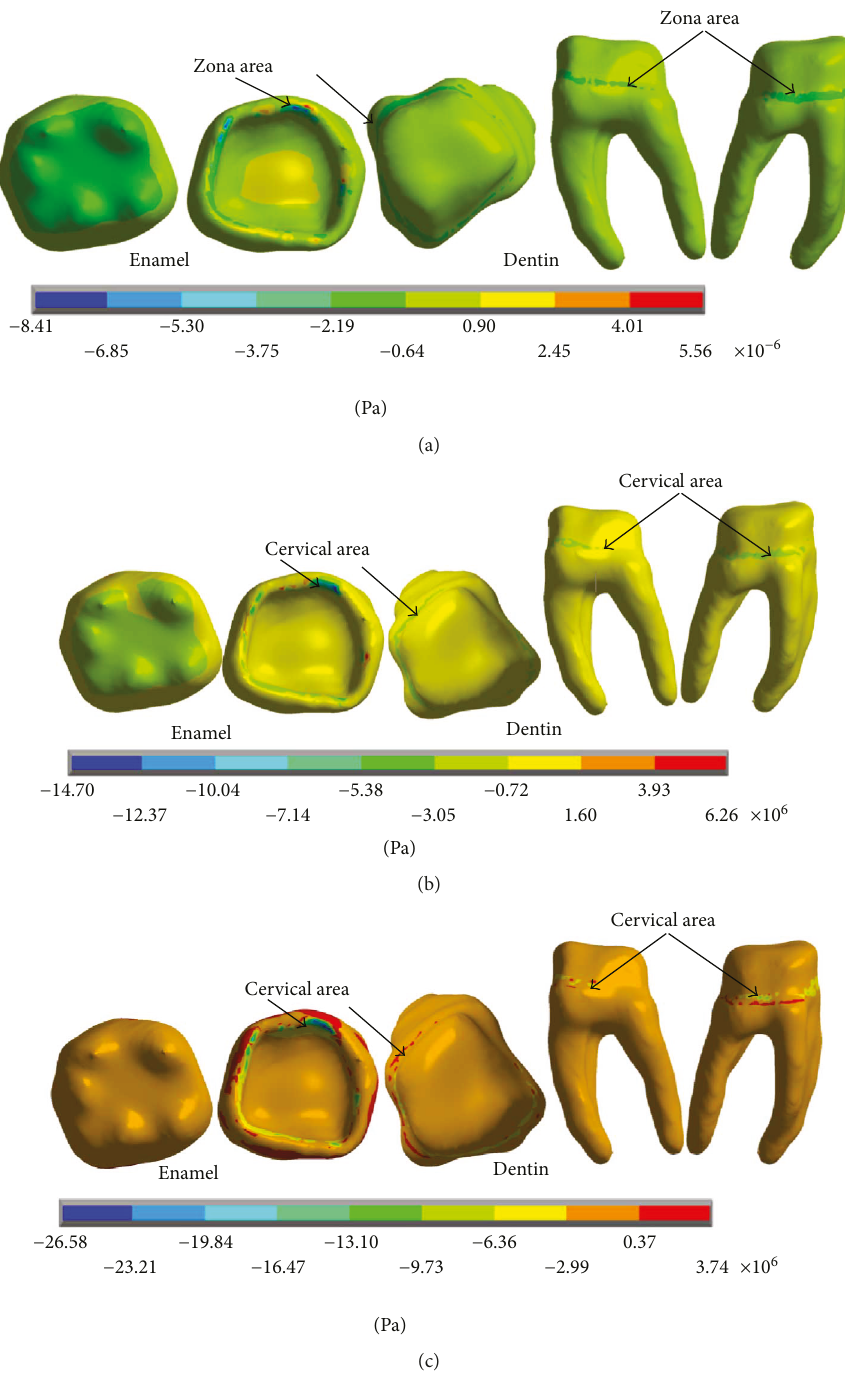
Figure 14: Nominal stress of the contact simulation. (a) x -axis. (b) y -axis. (c) z